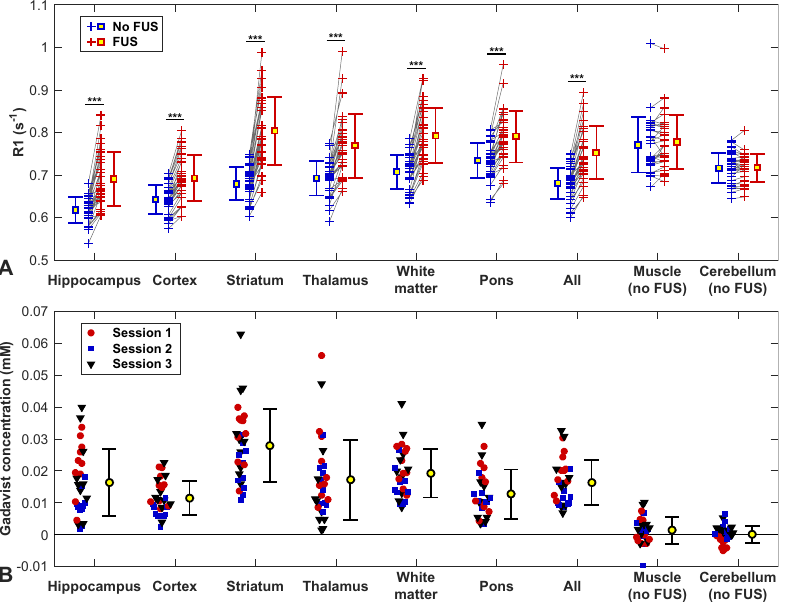
Figure 6. ( a ) Changes in R1 relaxation rate due to the delivery of Gadavist across the BBB for different structures for all animals in this study. Each + indicates the mean signal measured in that tissue structure in the sonicated hemisphere and in corresponding locations in the contralateral, non-sonicated hemisphere. In every individual sonication, R1 was higher in the sonicated side, and overall the difference between the sonicated and control hemispheres was significant for each structure ( *** P < 0.001). Regions in neighboring muscle and in the cerebellum were not sonicated, and the differences in R1 were not significant. ( b ) Difference in Gadavist concentration between the sonicated and control hemispheres, estimated using the R1 measurements and the relaxivity of the contrast agent (4.44 s − 1 · mM − 1